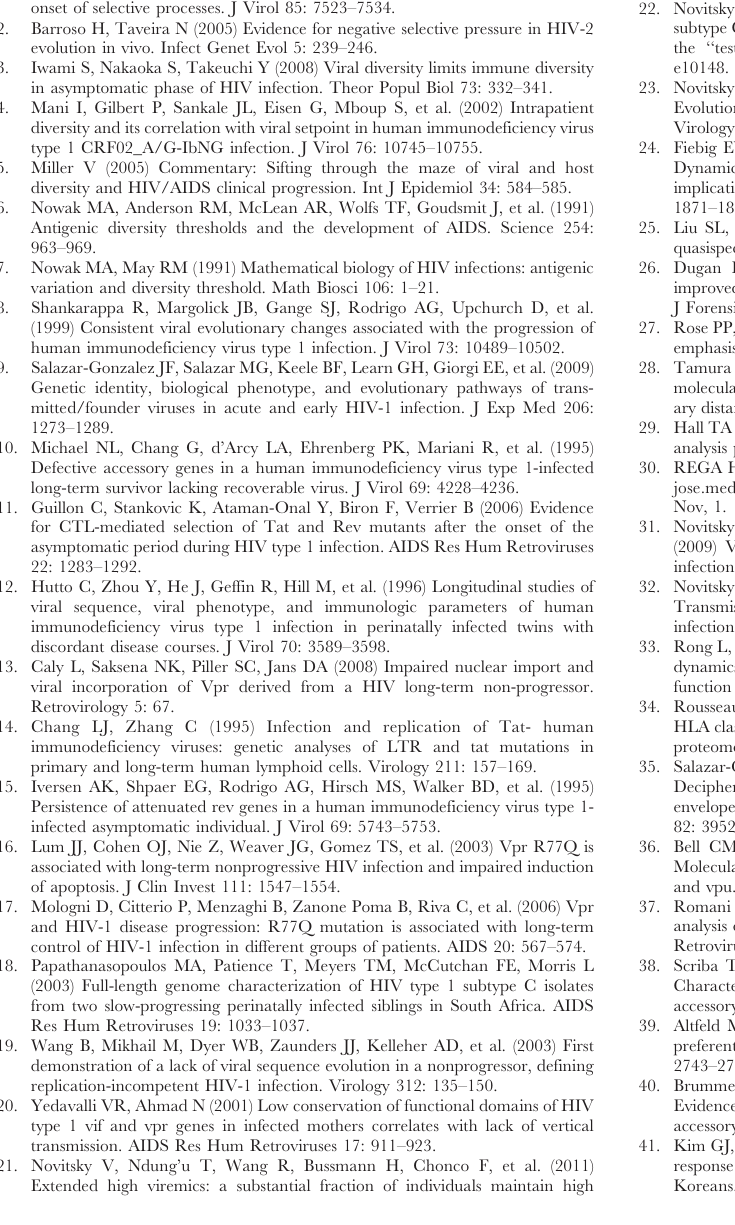
Table S1 Subject demographics, time points of sampling, HIV-1 RNA load, CD4 count, and Fiebig stage at